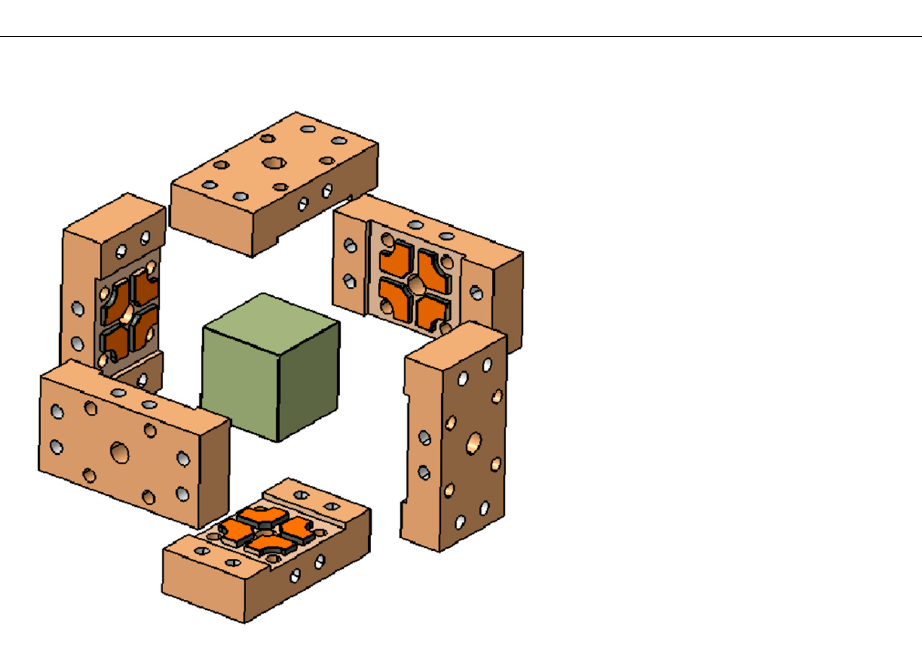
12 of 25 Figure 9. Error tree for the measurement of the non-gravitational differential acceleration along the satellite’s CoM-to-CoM direction. 3.2. The Candidate Accelerometer for NGGM In order to have the same level of performance along the three axes for linear accel- erations and to provide three pure angular accelerations, ONERA has proposed the new concept of the accelerometer, named MicroSTAR, with a cubic proof mass (PM) sur- rounded by six identical electrode plates (Figure 10). The principle of measurement of MicroSTAR is identical to the previous accelerometers utilized on GOCE [28] or GFO [29]: the PM is suspended at the center of the electrode cage with electrostatic forces, with the control being ensured by a capacitive measurement of the motion of the PM with respect to the electrode cage. With the electrode cage being fixed inside the satellite, the electro- static forces applied on the PM are representative of the relative acceleration of the PM